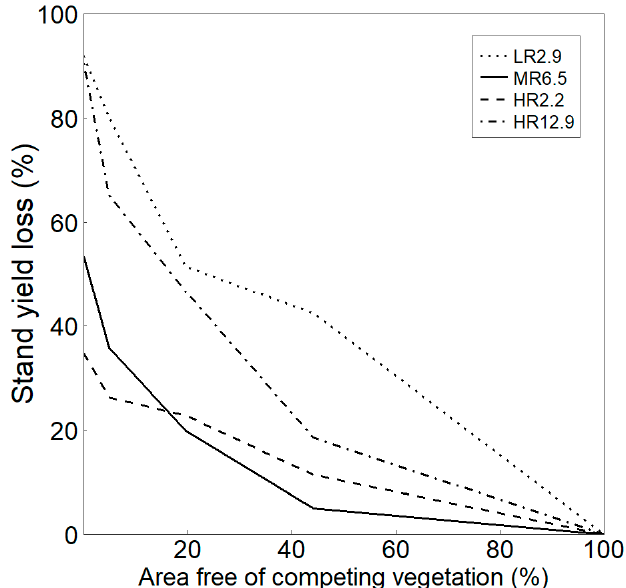
Figure 2. Proportion of stand yield loss under different vegetation control intensity across a rainfall and the amount of competing vegetation biomass gradient. The study sites were characterized according to their annual mean rainfall (LR, MR or HR) and by the amount of weed biomass produced (Mg ha − 1 ) during the first growing season.